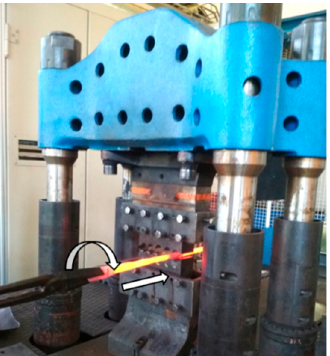
Figure 1. Rolling the heated container on the laboratory rolling mill. Figure 2. Forging the bar in the shaped die on the hydraulic press.